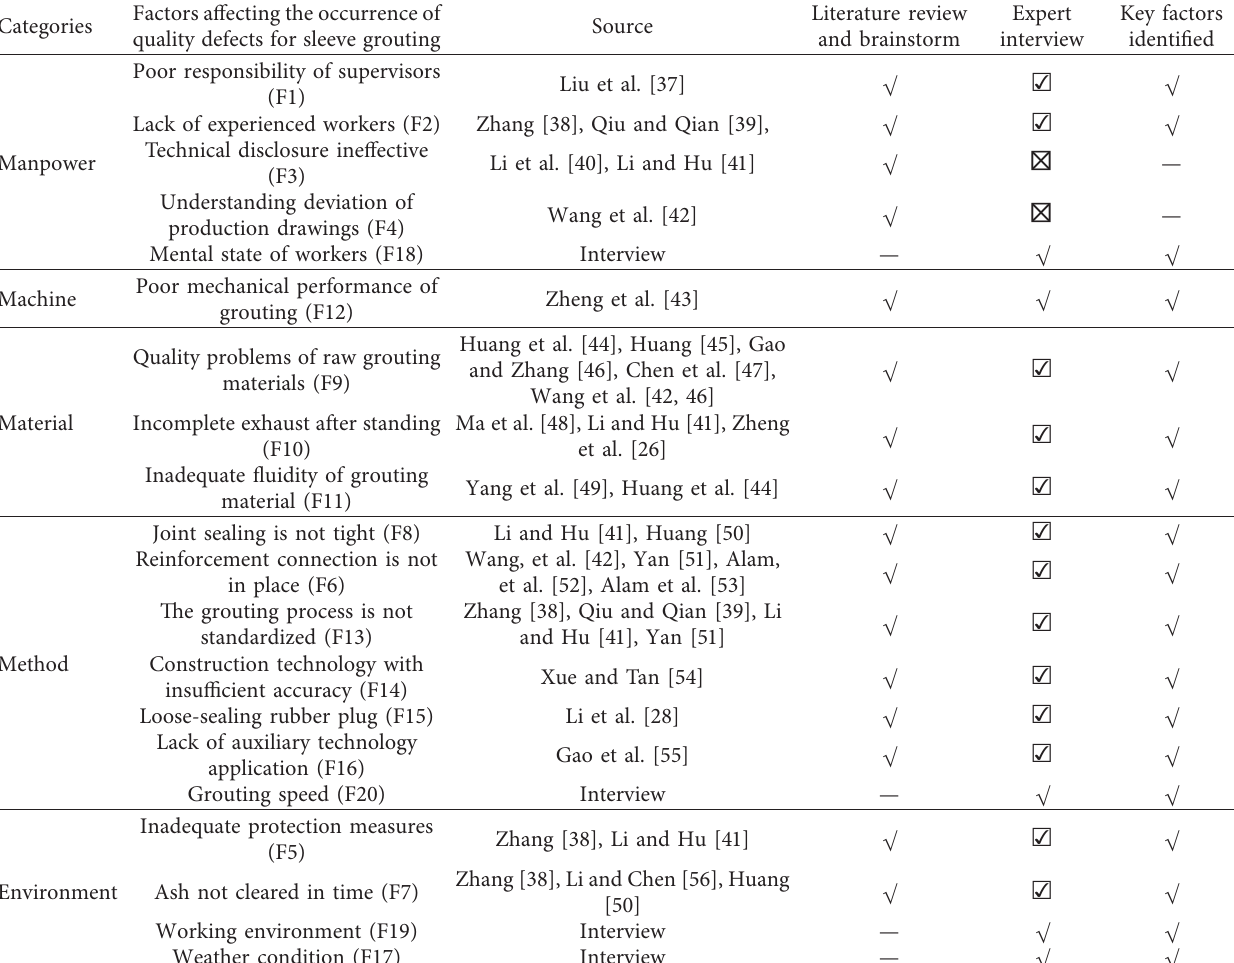
Table 2: Factors of sleeve grouting quality